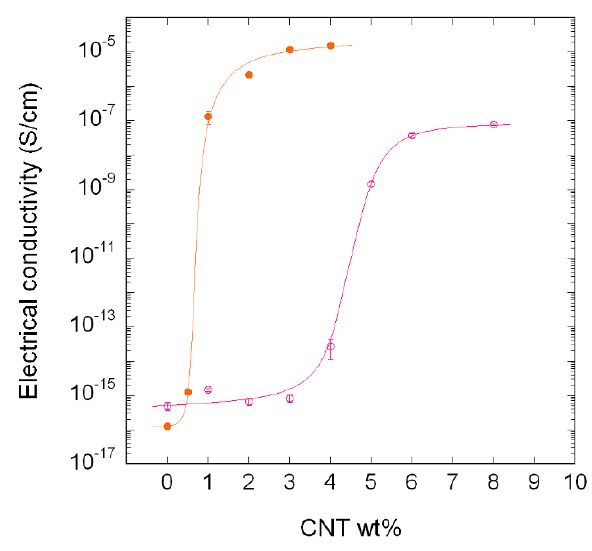
Figure 6. Glass transition temperature ( T g ) of the unfilled PA410/PA6 blends ( ○ ) and PA410/PA6/CNT NCs (●) vs. CNT and PA6 content. ) and of PA410/PA6/CNT NCs ( (cid:35)